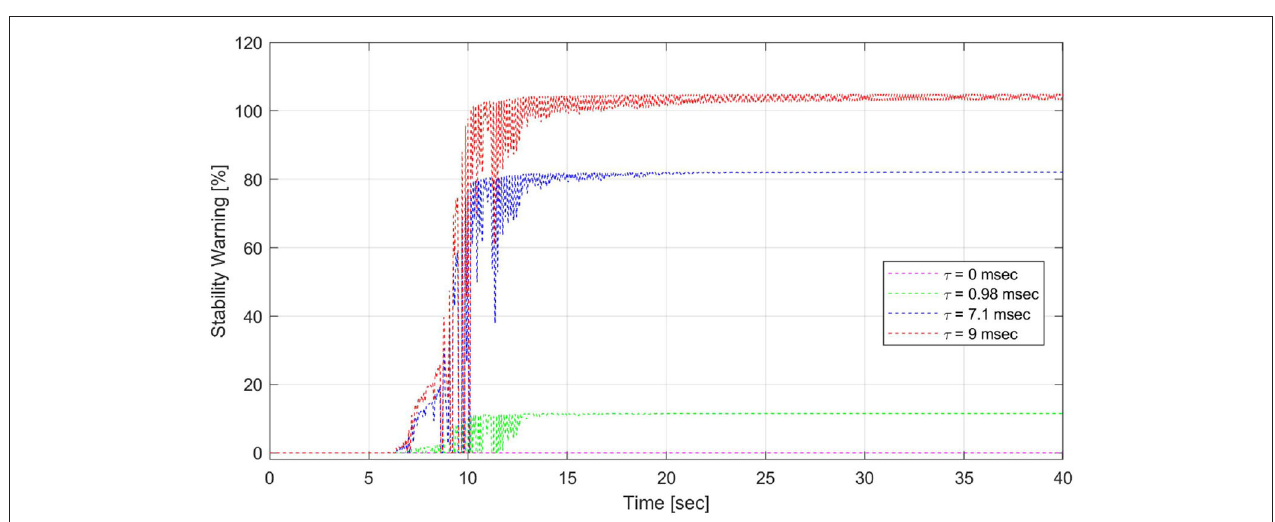
FIGURE 7 | Stability warning indicator ( SW ) for different delay